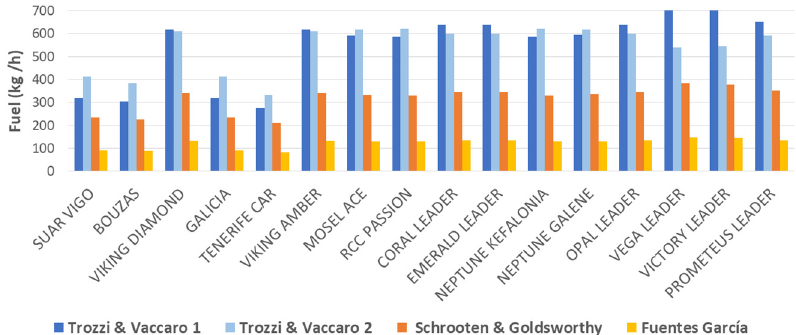
Figure 4. Fuel consumption comparison through the Trozzy and Vaccaro, Schrooten and Goldsworthy, and Fuentes García methods.